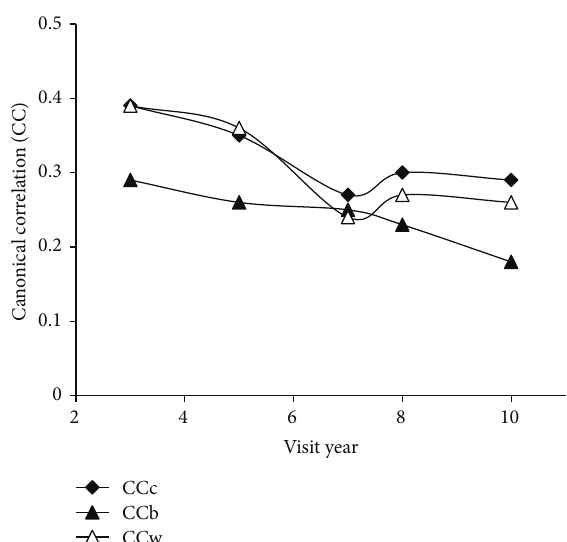
Figure 3: Canonical correlation between obesity correlates and body composition by visit year. Obesity correlates: income category, race, maturation stage, habitual physical activity questionnaire score (HAQ), 3-day activity diary score (3d AD), racial interaction HAQ, racial interaction 3d AD, average energy density, average caloric intake, average dietary saturated fat percent, and average fiber intake; body composition: BMI and body fat percent. Lines representstratifieddatafromblack(CCb)andwhite(CCw)girlsand combined (CCc)